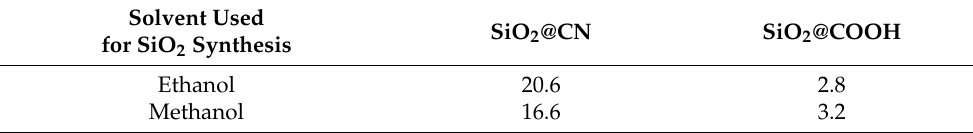
Table 3. Number of function (mol) per nm 2 core ( µ